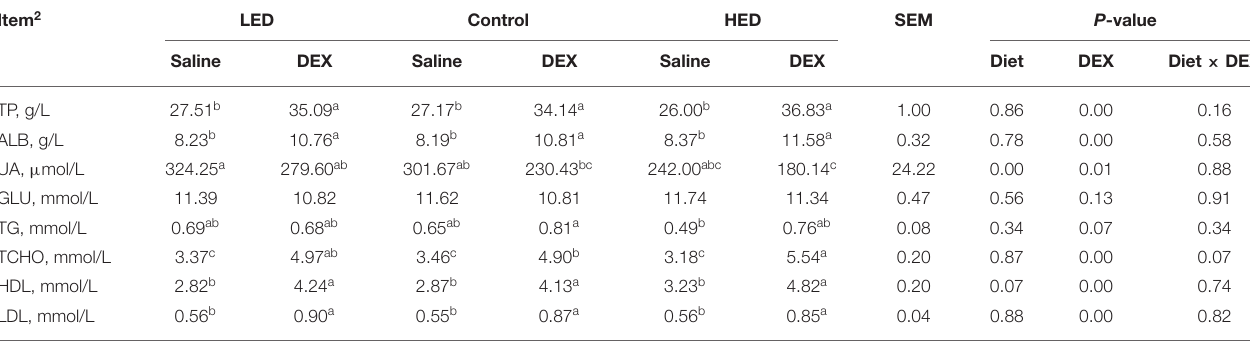
TABLE 6 | Effects of DEX on plasma parameters in 13-day-old broilers fed with different energy level diets 1 . Item